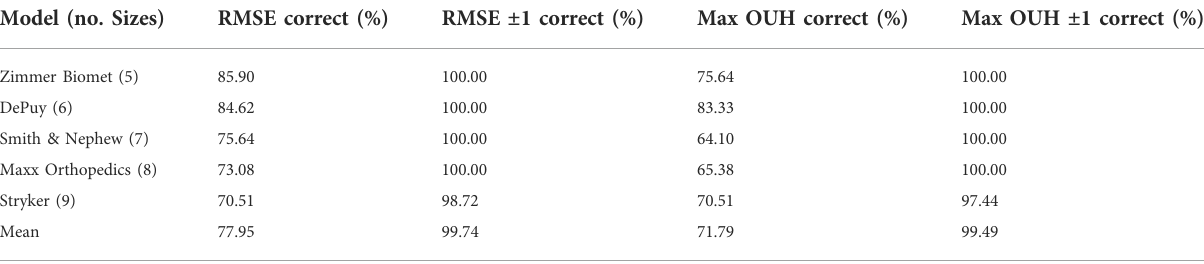
TABLE 4 Femur component size prediction accuracies for each manufacturer model sizings. Size prediction accuracy is shown in terms of RMSE and maximum OUH, as well as allowing for ± one model size. Model (no. Sizes)